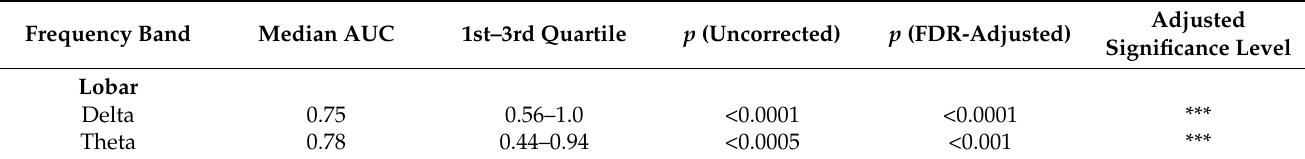
Table 3. Localization performance of node degree values for invasive EEG seizure onset.